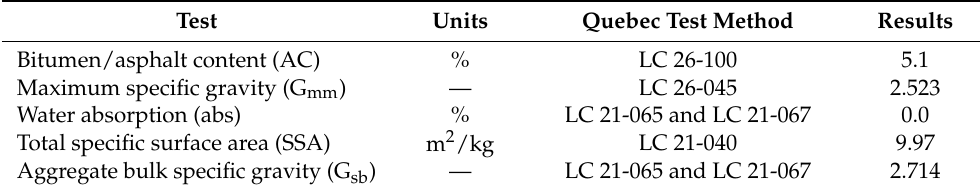
Table 3. Reclaimed asphalt pavement (RAP)